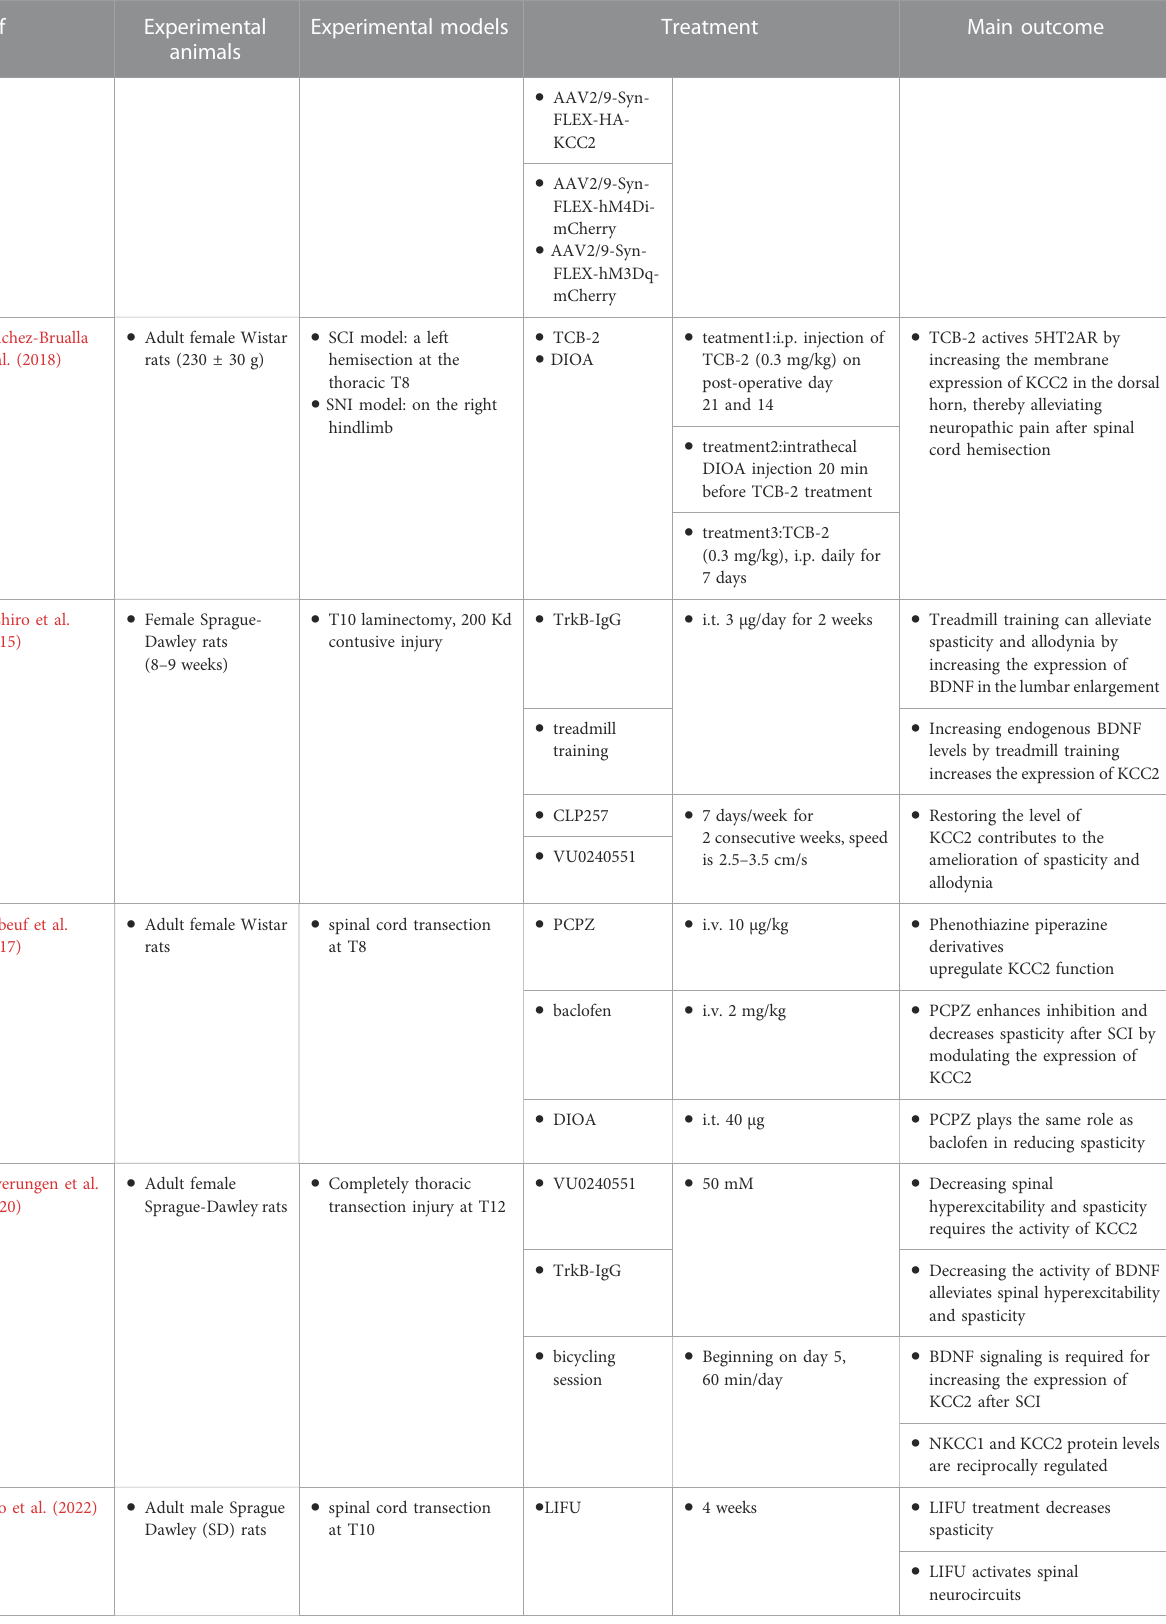
TABLE 1 ( Continued ) Summary of animal experiments related to the regulation of KCC2 and NKCC1 after spinal cord